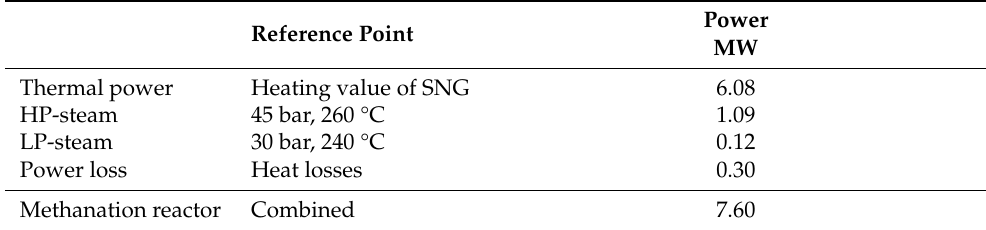
Table 10. Waste heat potential of the methanation reactor equipment. HP = high pressure and temperature; LP = low pressure and